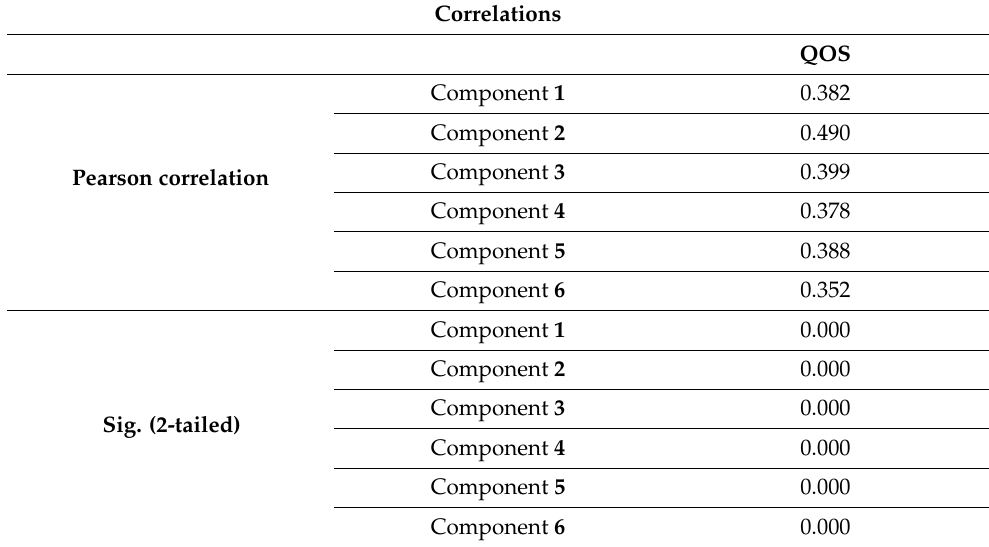
Table 6. Pearson correlation